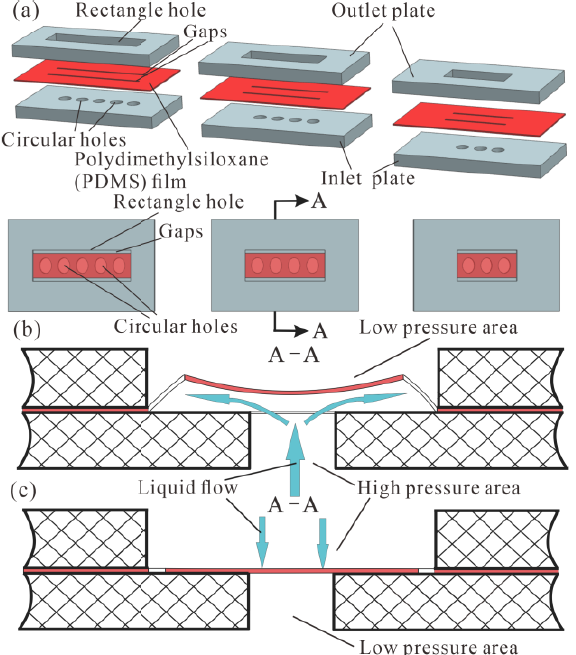
Figure 1. The check valve unit: ( a ) structure of the valve with 5, 4 and 3 inlet holes; ( b ) open mode; ( c ) closed mode.